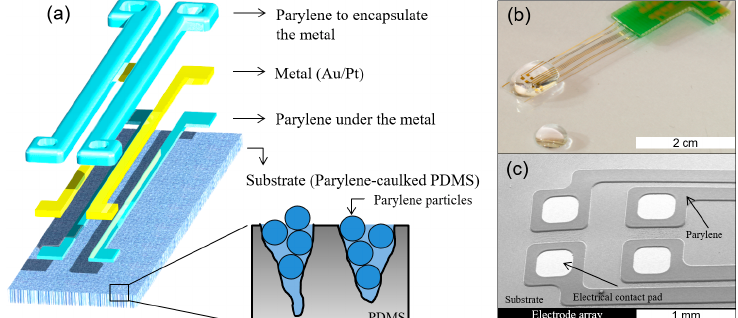
Figure 1. ( a ) Schematic image of the electrode array based on parylene-caulked PDMS; ( b ) photographic image of the completed electrode array connected with a printed circuit board (PCB), shown with a water droplet; and ( c ) SEM image of the completed electrodes.